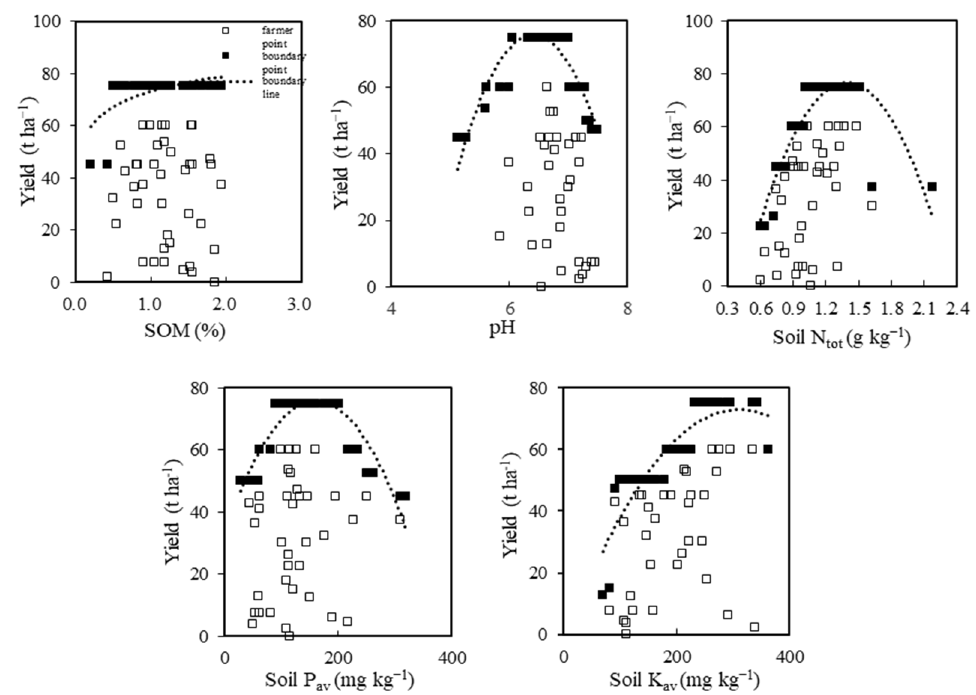
Figure 4. Relationships between apple yield and the main soil indicators in 2016 for Beiquan Village, Hebei, China. The dotted black line represents the boundary line in 2016 and boundary lines represent the polynomial curves for four soil indicators, namely the soil N tot , soil P av , soil K av , and soil pH.